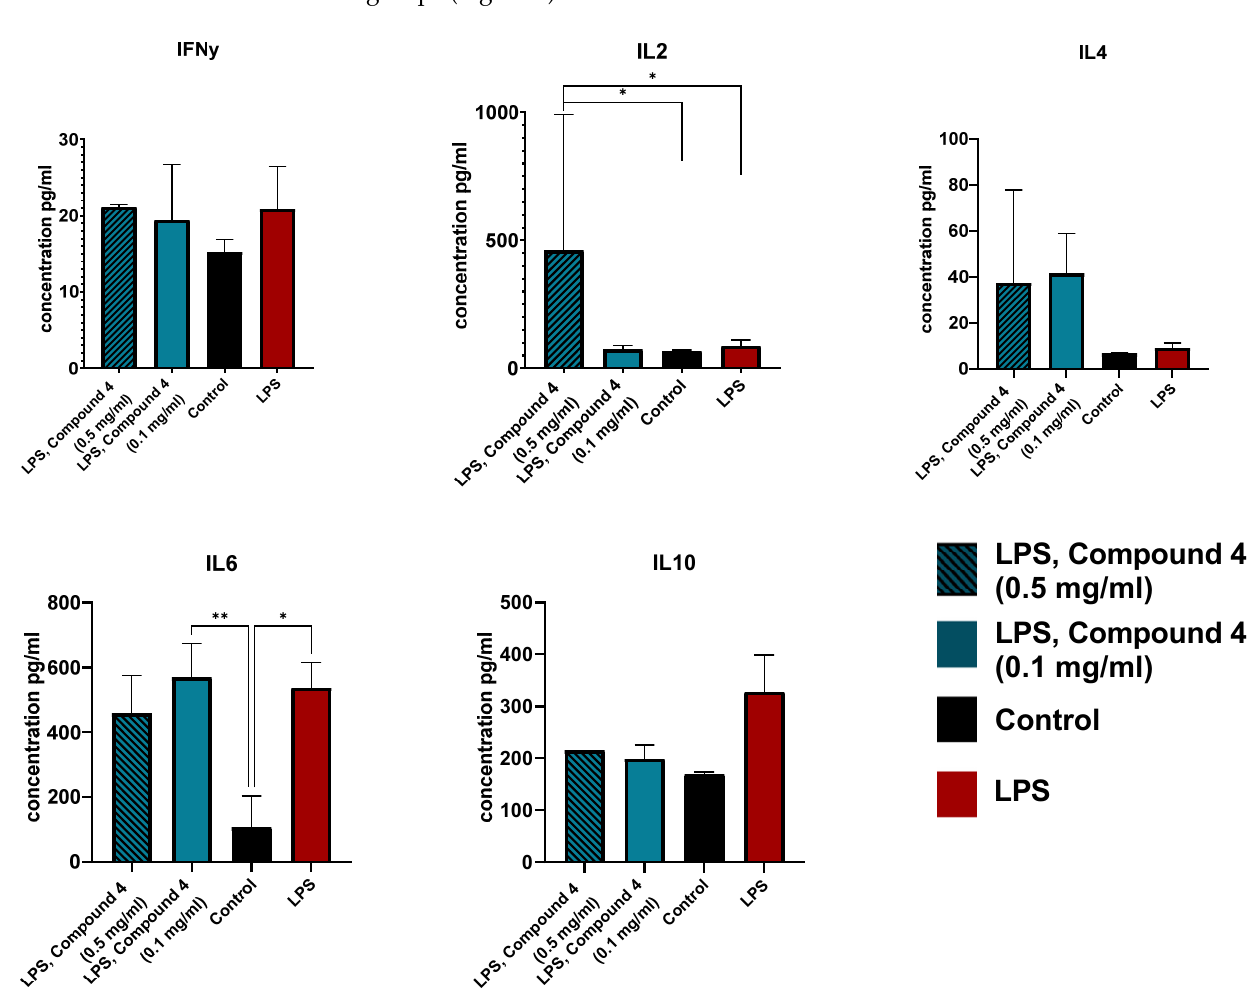
Figure 2. Cytokine secretion in RAW 264.7 cells. Cells were treated with LPS (red), LPS and 0.1 mg/mL Compound 4 (blue), LPS and 0.5 mg/mL Compound 4 (striped blue), or control (left intact) (black). The concentration of the cytokines in the supernatant was measured using a CBA kit. Two replicative experiments were performed and the data are presented as mean cytokine concentration in pg/mL. ** p < 0.01, * p <